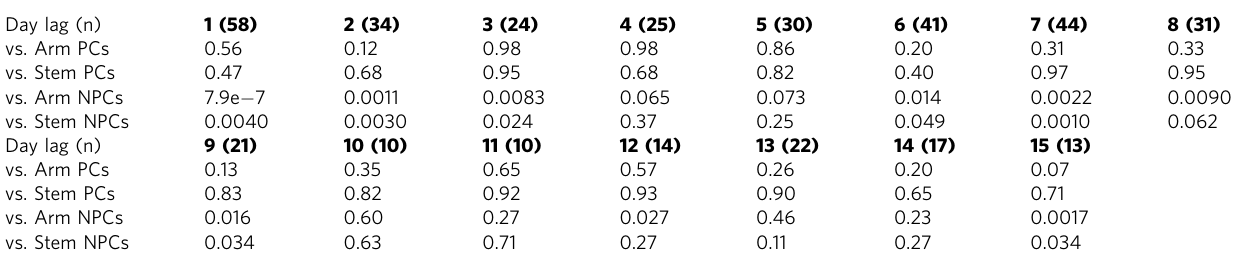
Table 3 One-sided signed-rank signi fi cance values for the probability splitter vs. place and non-place cells stay active, event-rate matched ( n = session